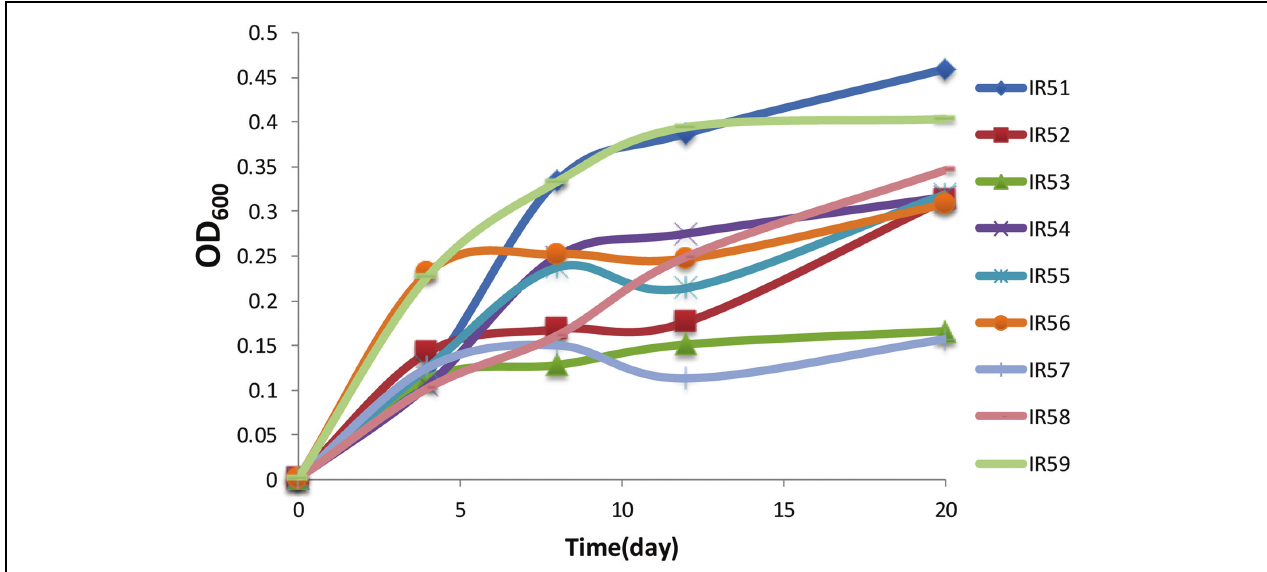
FIGURE 1 | The growth of the nine consortia on a polycyclic aromatic hydrocarbon (PAH) mixture of phenanthrene (100 mg/liter), fluoranthene (10 mg/liter), anthracene (10 mg/liter), and pyrene (10 mg/liter). Cell growth was determined by OD 600 from 4 to 20 days. Incubation was at 28 ◦ C in the dark in a constant shaker.